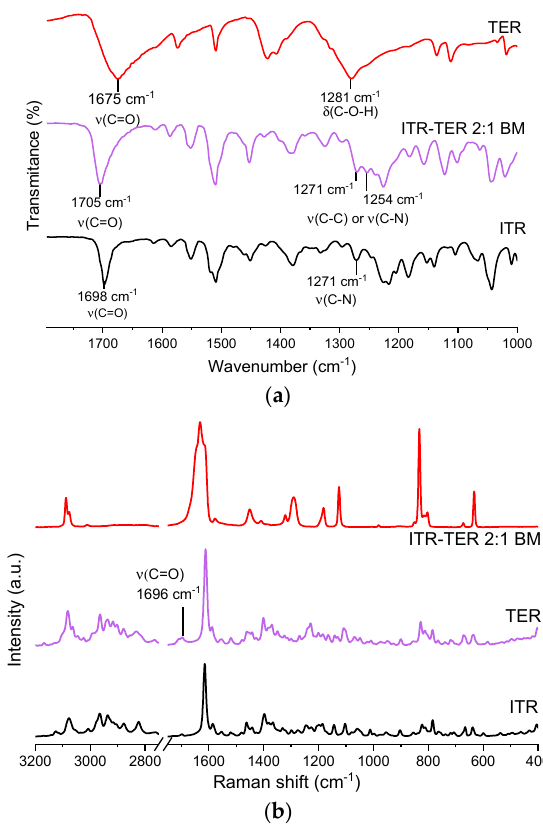
Figure 6. ( a ) Fourier-transform infrared spectroscopy (FT-IR) spectra of the ITR and TER